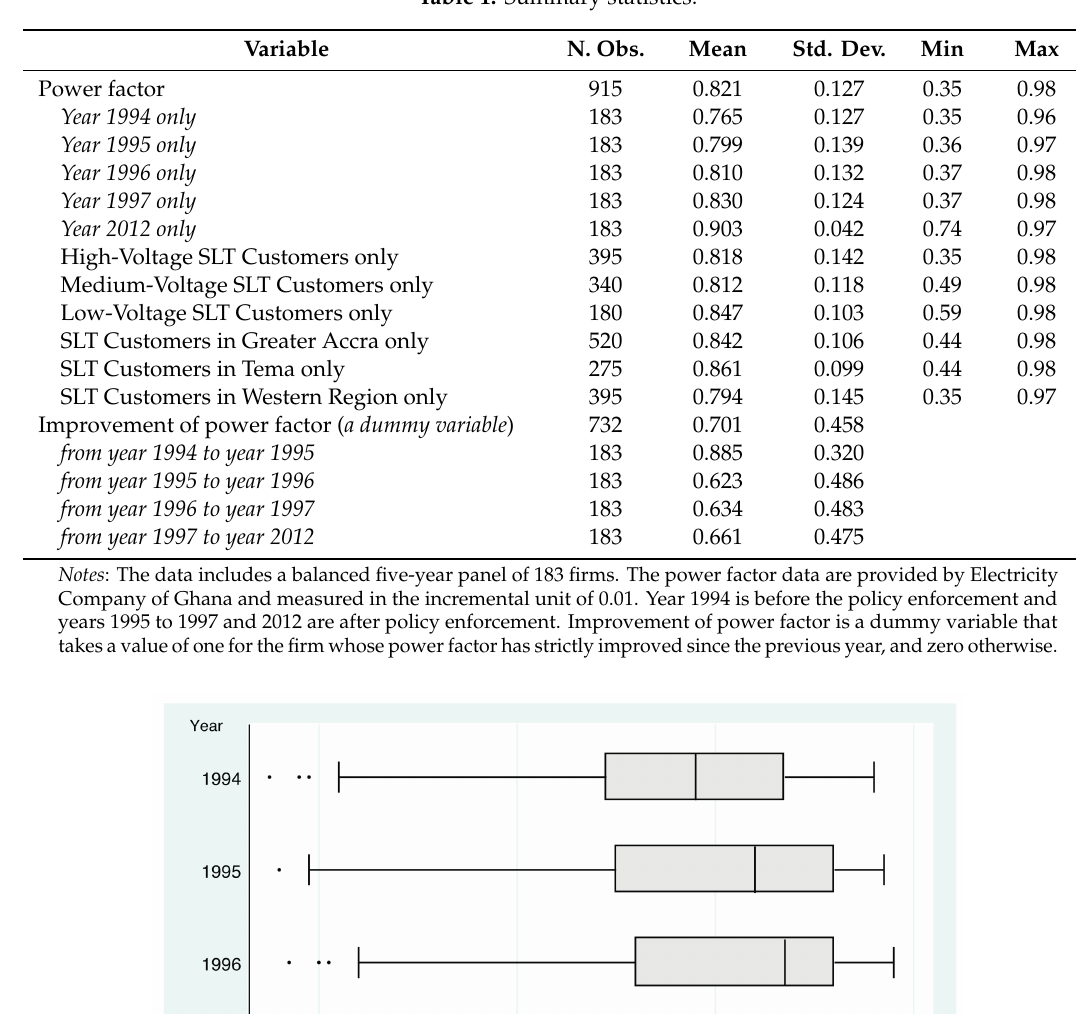
Table 1. Summary statistics.